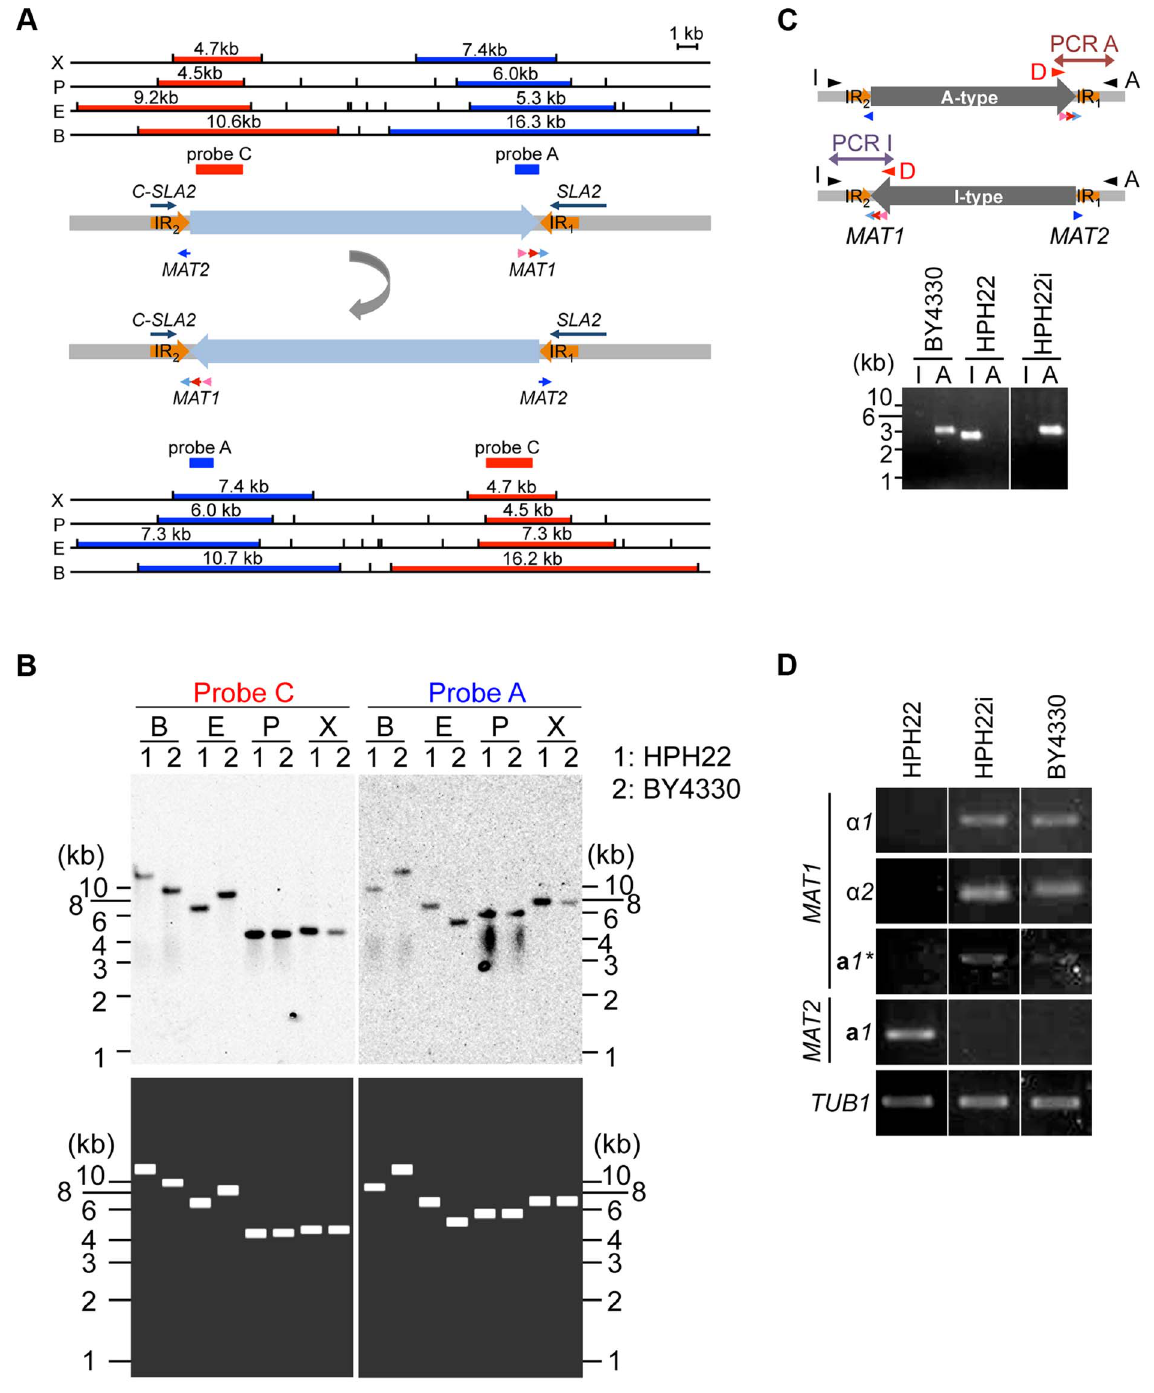
Figure 4. Inversion of the MAT intervening region alters the expression status of mating type genes. (A) Schematics of the chromosomal region surrounding MAT1 and MAT2 . a 1 , a 2 , a 1* , and a 1 genes are indicated by pink, red, and light and dark blue arrows, respectively. IR regions are shown as thick orange arrows. DNA fragments used as probes for Southern blot analysis in (B) are shown as dark blue (probe A) or red (probe C) bars. The upper schematic shows the draft genome sequence. The lower schematic shows the predicted DNA sequences after the inversion between IR regions. Upper and lower panels showrestriction enzyme sites deduced fromthe DNA sequences and the size of the DNA fragment hybridized by eachprobe. X, Xho I;P, Pst I;E, Eco RI;B, Bam HI. (B) Two types of chromosome configuration in different wild-type strains. Genomic DNA of HPH22 (indicated as 1)andBY4330(indicated as 2) were prepared from logarithmically growing cells in YPDS medium and analyzed by Southern blotting using probes A and C (upper panel). The lower panel shows the results predicted from Upper (U) and Lower (L) schematics in (A). (C) PCR amplification of the I- or A-type MAT1 locus (reaction I with Primer_I/Primer_D or reaction A with Primer_A/Primer_D). The presence of the I product and absence of the A product for HPH22 indicates that the chromosome is in the I-type orientation. HPH22i and BY4330 have an A-type chromosome. (D) Mating type genes are transcriptionally active at position 1 and repressed at position 2. The expression of a 1 , a 2 , a 1* , and a 1 genes was examined by RT-PCR. RNA samples were prepared from logarithmically growing wild-type cells in YPDS medium at 30 u C (HPH22, HPH22i, and BY4330). HPH22i is a clone isolated from HPH22 (Fig. S4B; see text).